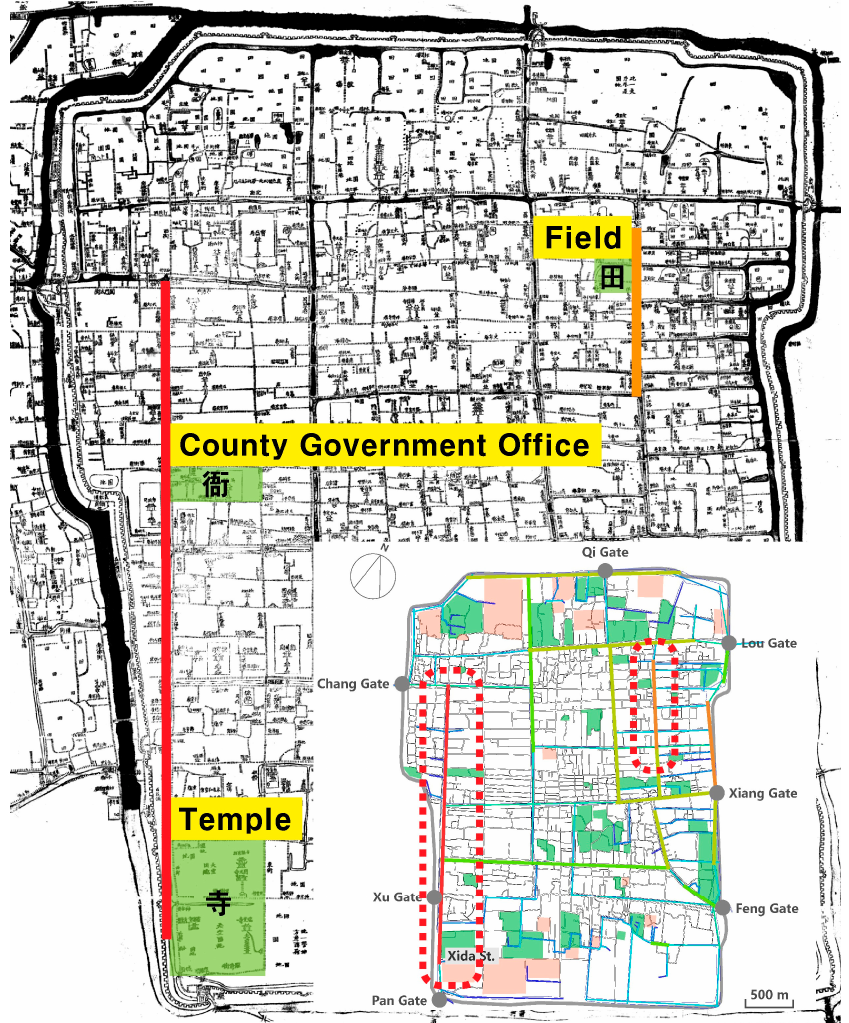
Figure 6. The distribution of green space around the canals with the highest and second-highest degrees of integration in the Map of Suzhou City